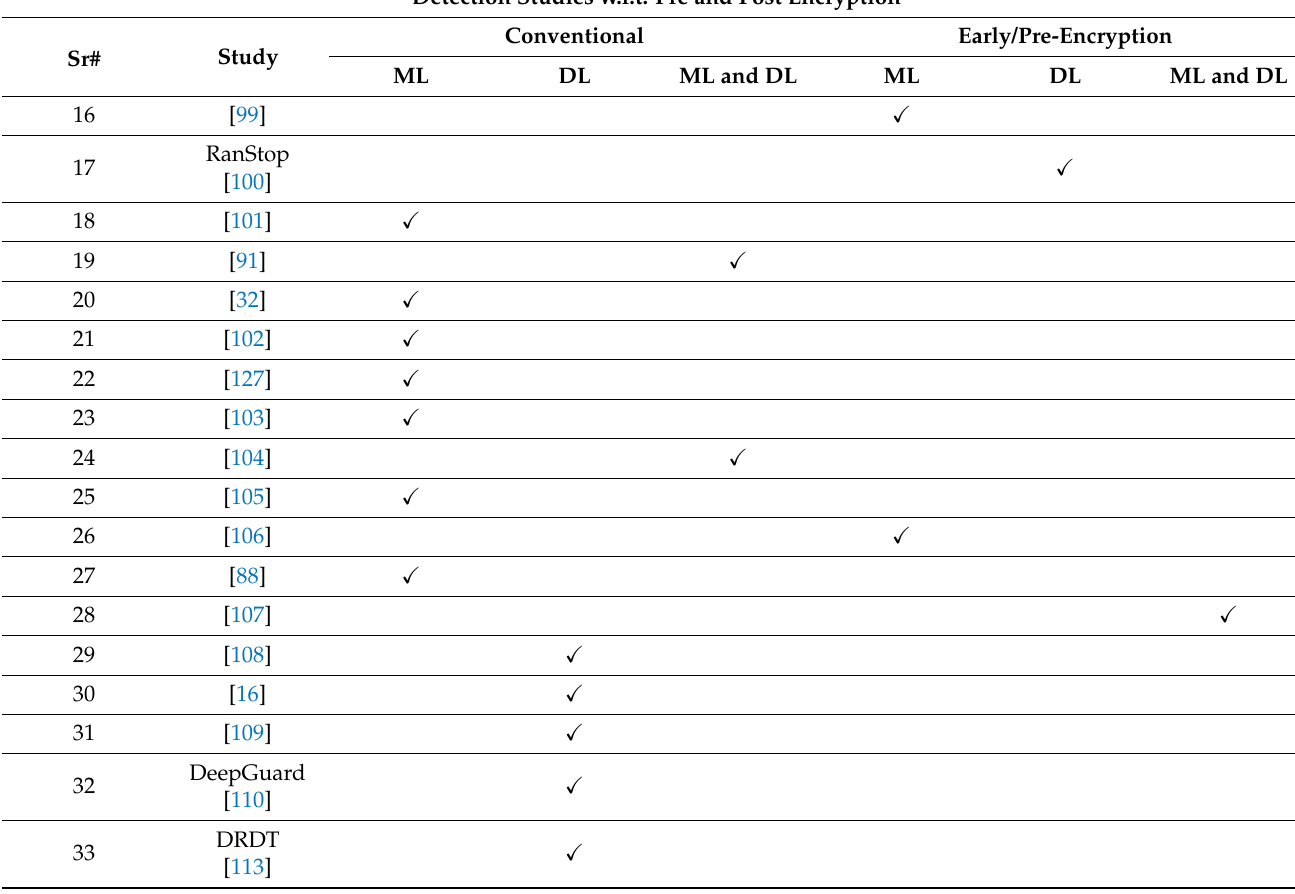
Table 6. Cont. Detection Studies w.r.t. Pre and Post